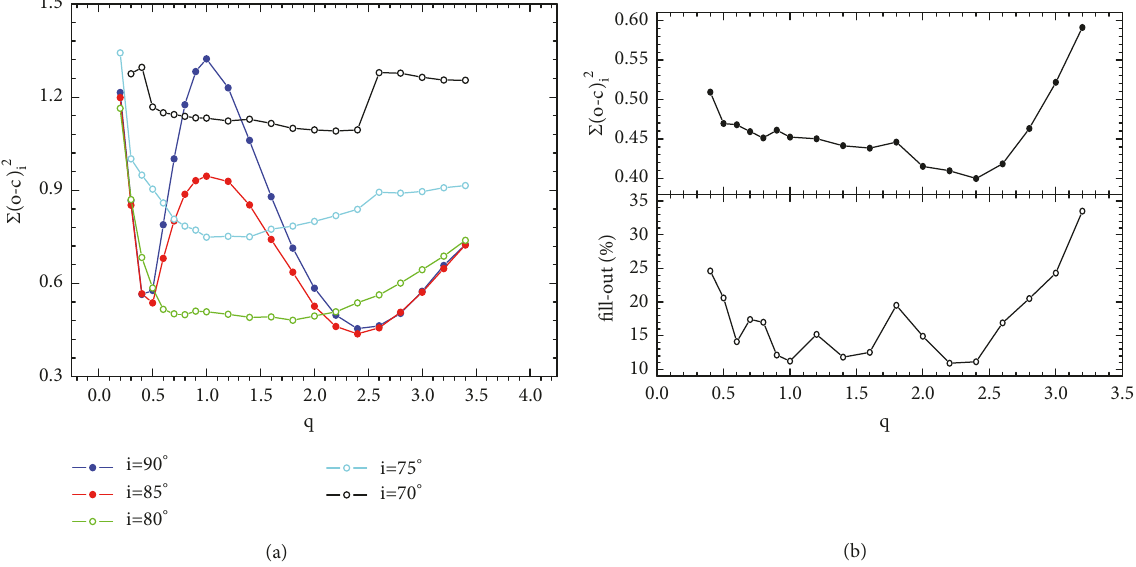
Figure 6: The relations of 𝑞 − 𝑖 (a), 𝑞 − Σ and 𝑞 − 𝑓 (b) derived from 𝑉𝑅 𝑐 light curves in